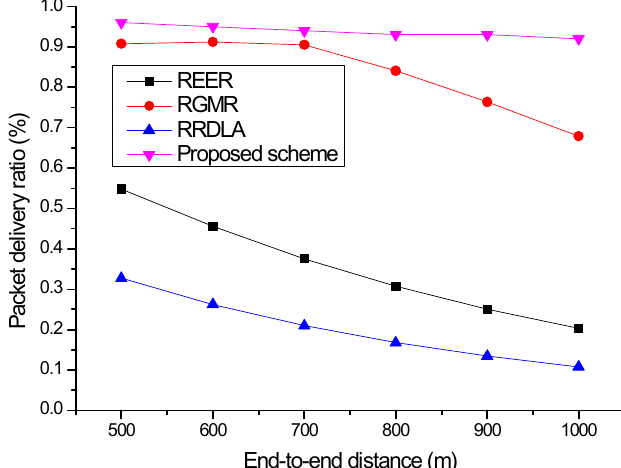
Figure 7. Packet delivery ratio vs. end-to-end distance with 80% of link